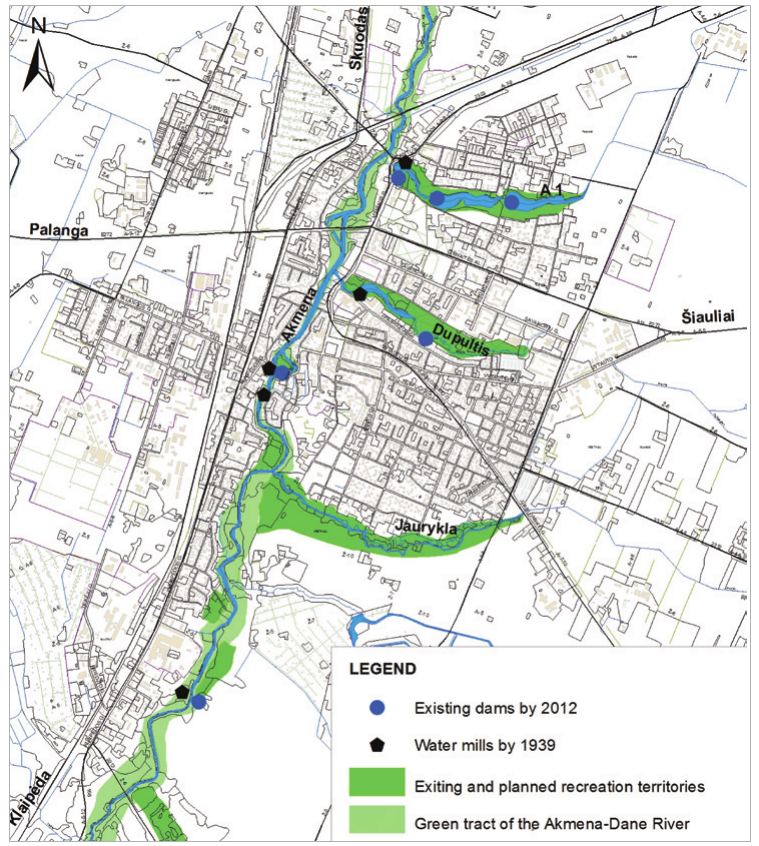
Fig. 7. Green corridor of the Town of Kretinga with the marked hydrotechnical impoundments and adjacent present or planned recreational